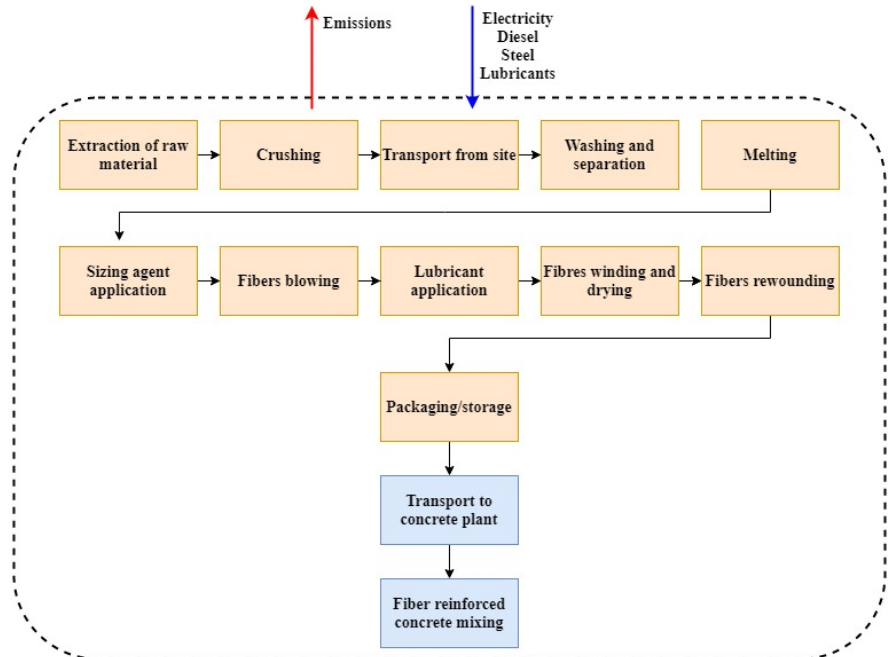
Figure 1. Schema of basalt fiber production.